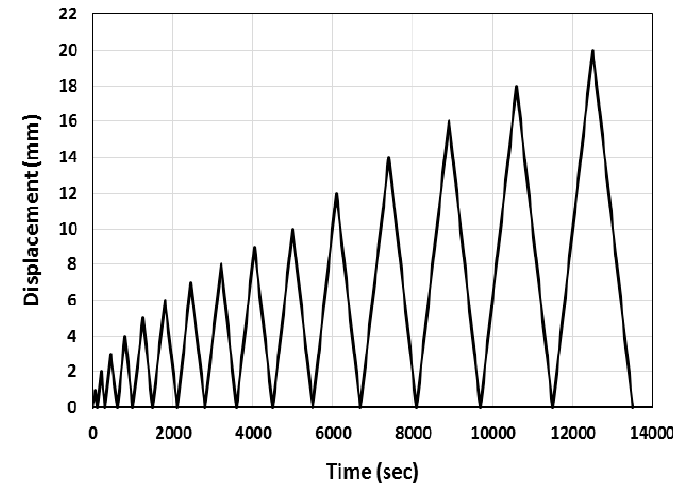
Figure 4. Cyclic loading pattern.